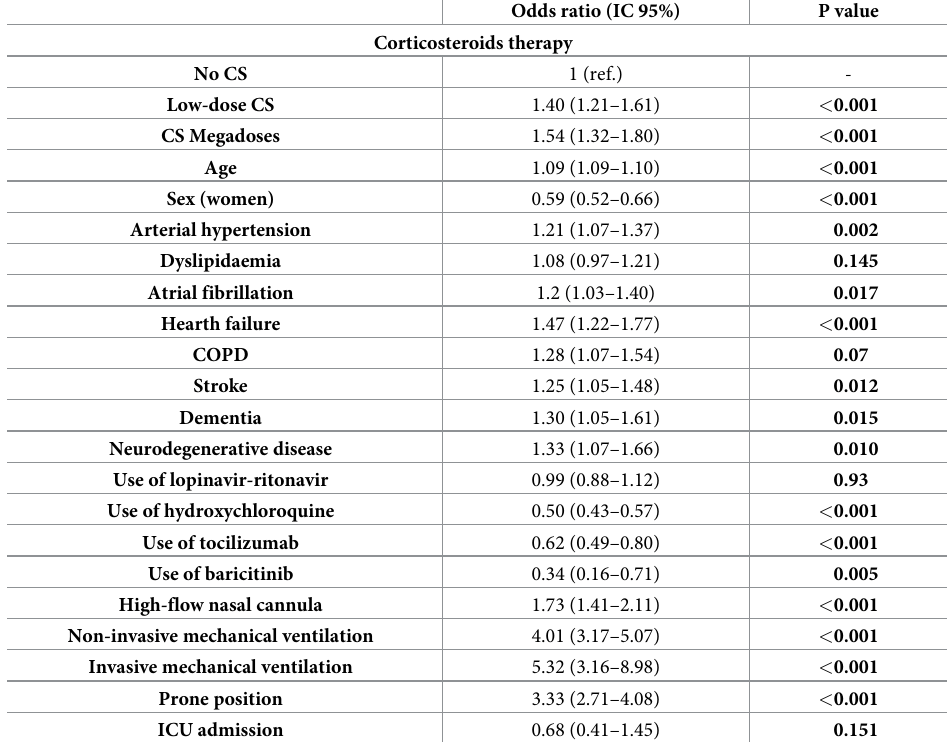
Table 7. Megadoses and mortality (multivariate analysis adjusted according to patient age, comorbidities and other